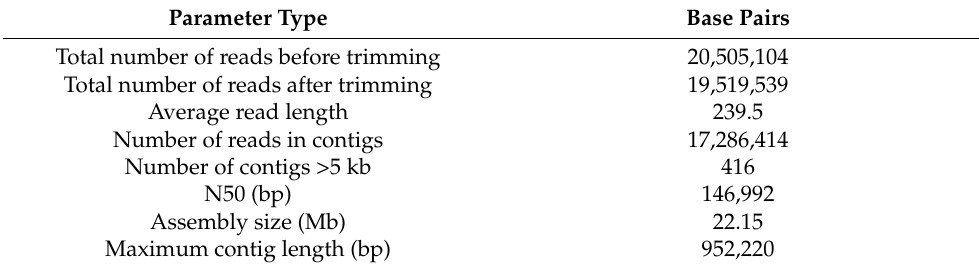
Table 1. Statistics of raw sequence data from which metagenome-assembled genomes (MAGs) were recovered through de novo assembly.